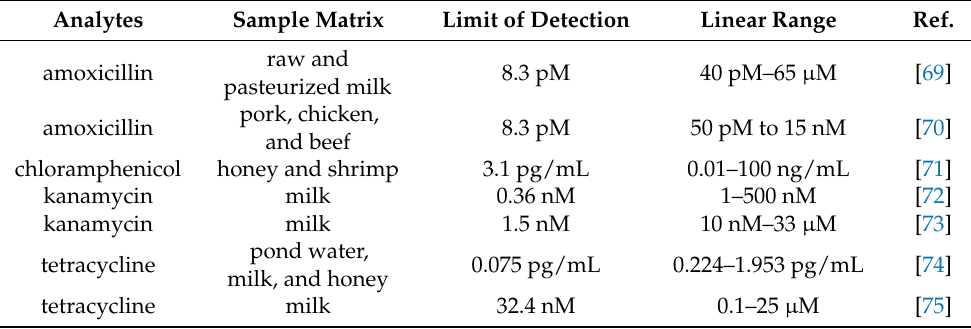
Table 3. Brief summary of current ECL biosensors for detection of antibiotics.